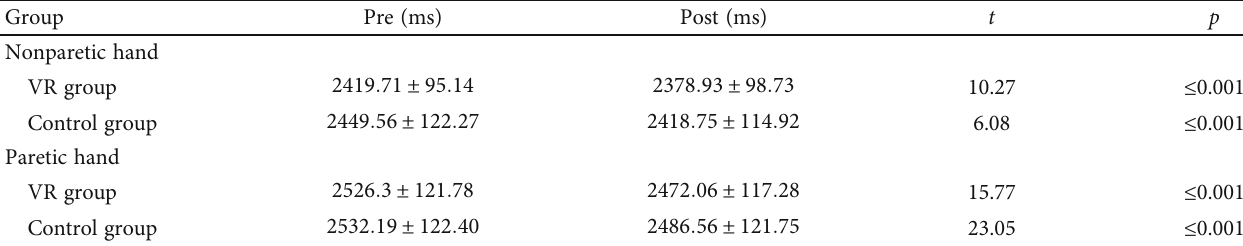
Table 3: Comparison of CNV latency before and after intervention during nonparetic and paretic hand movements. Group Pre (ms) Nonparetic hand Control group Paretic hand VR group Control group